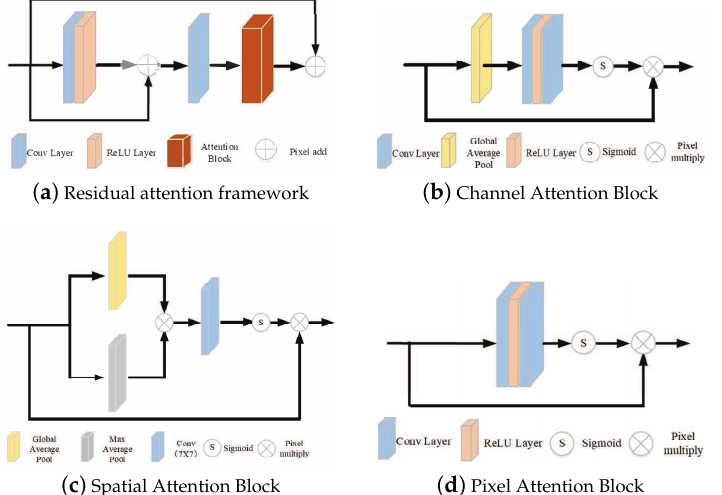
Residual attention Fig. 2. Residual attention framework Figure 2.